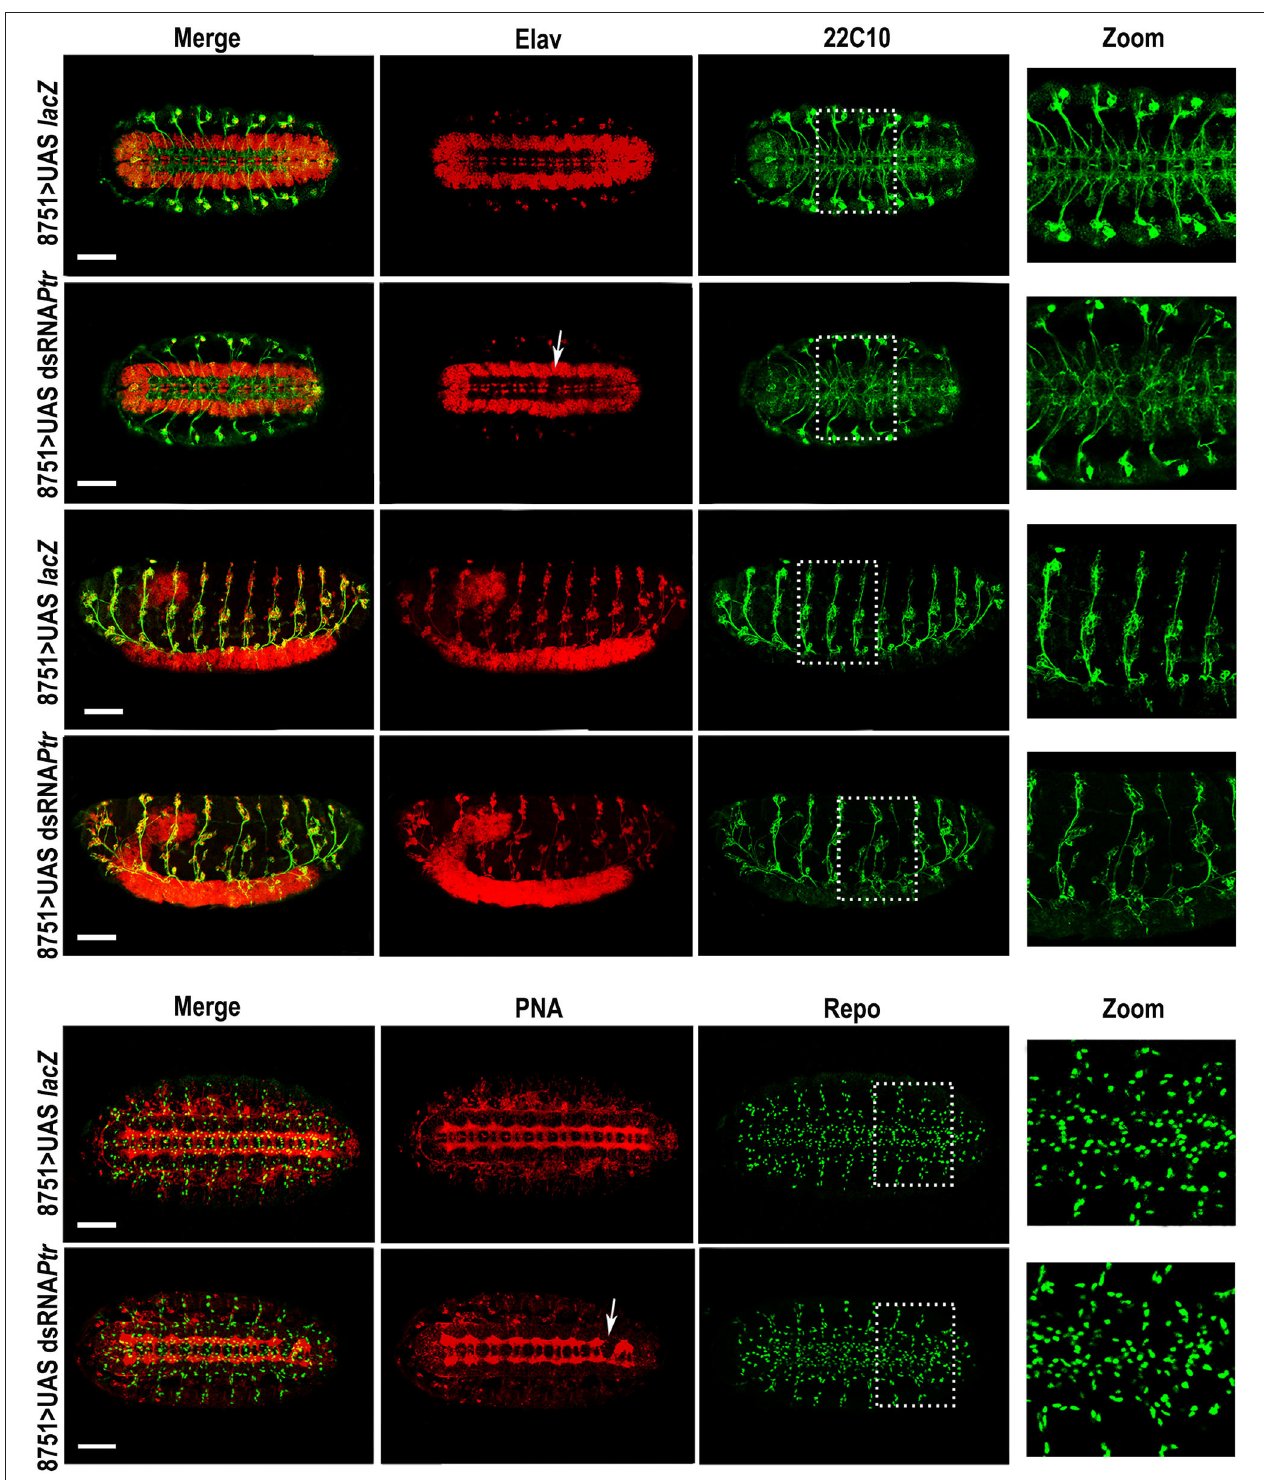
FIGURE 2 | Downregulation of Ptr specifically driven to nervous system recapitulates several morphological changes found in Ptr null mutants. Z-stack immunofluorescence against Elav and 22C10 (the four upper rows) or PNA and Repo (the two bottom rows). The analysis was carried out on D. melanogaster late embryos (stage 15/16). Arrows indicate the alterations seen in the primary tracts. The right column shows a higher magnification of the alterations found inside the dashed boxes in each image. In all the figures, embryos are oriented anterior to the left. To observe the nervous system, most images are ventral views of the embryo, except the third and fourth rows that show lateral views where the ventral side of the embryo is down. Bars: 50 µ m.